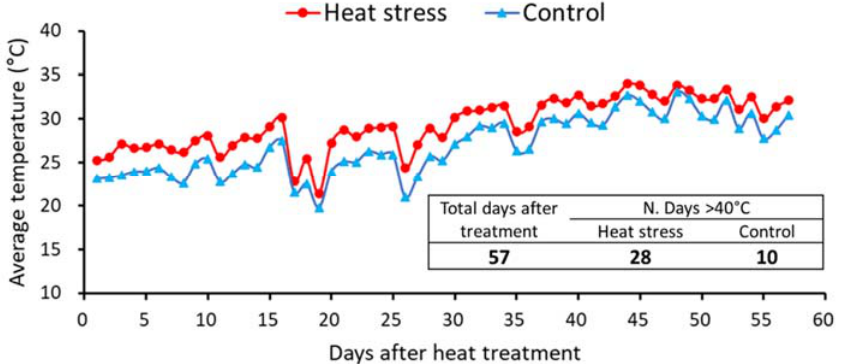
Figure 1. Fruit phenotypes of HR17, HR22, and HR24 grown in control-condition greenhouse on 57th day after treatment.